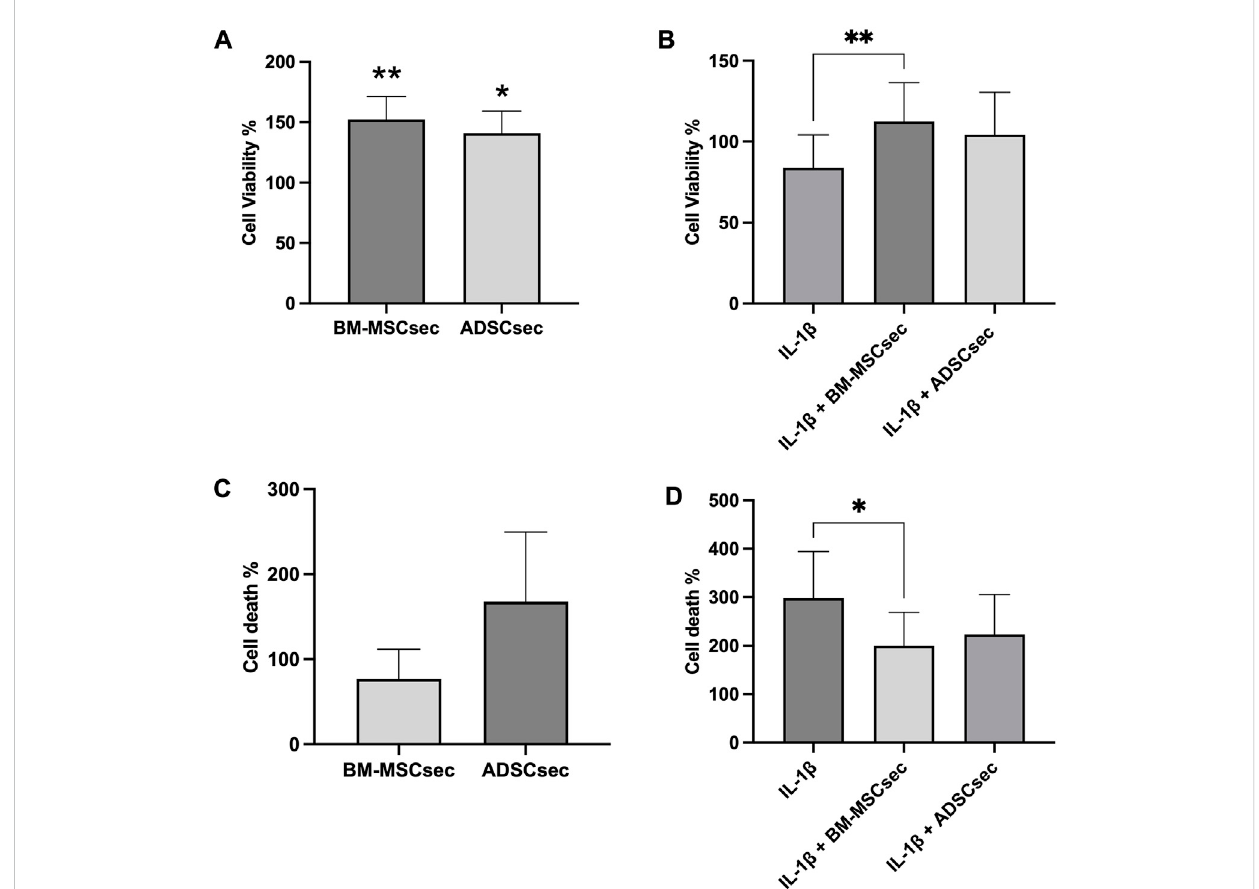
FIGURE 4 MSC-derived secretome enhanced hNPC viability and reduced cell death. The LIVE/DEAD assay showed that both BM-MSCsec and ADSCsec signi fi cantly increased cell viability compared to the control group (A) . Following IL-1 β pretreatment, BM-MSCsec signi fi cantly rescued hNPC vitality compared to cells treated with IL-1 β alone (B) . (C) BM-MSCsec and ADSCsec treatment did not substantially impact on cell death. (D) After IL-1 β pretreatment,BM-MSCsecsigni fi cantly reducedthenumberof dead cellscomparedto hNPCs treatedwith IL-1 β alone.Resultswerenormalizedto the control group and expressed as percent variation. * p < 0.05, ** p <